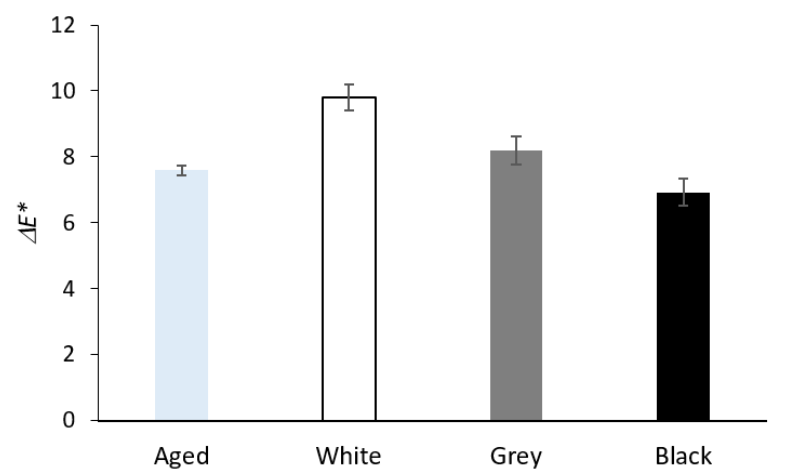
Figure 8. The total color difference of Whatman Grade 1 paper after artificial aging without contact with PE foam (Aged) and in contact with the tested PE foams.